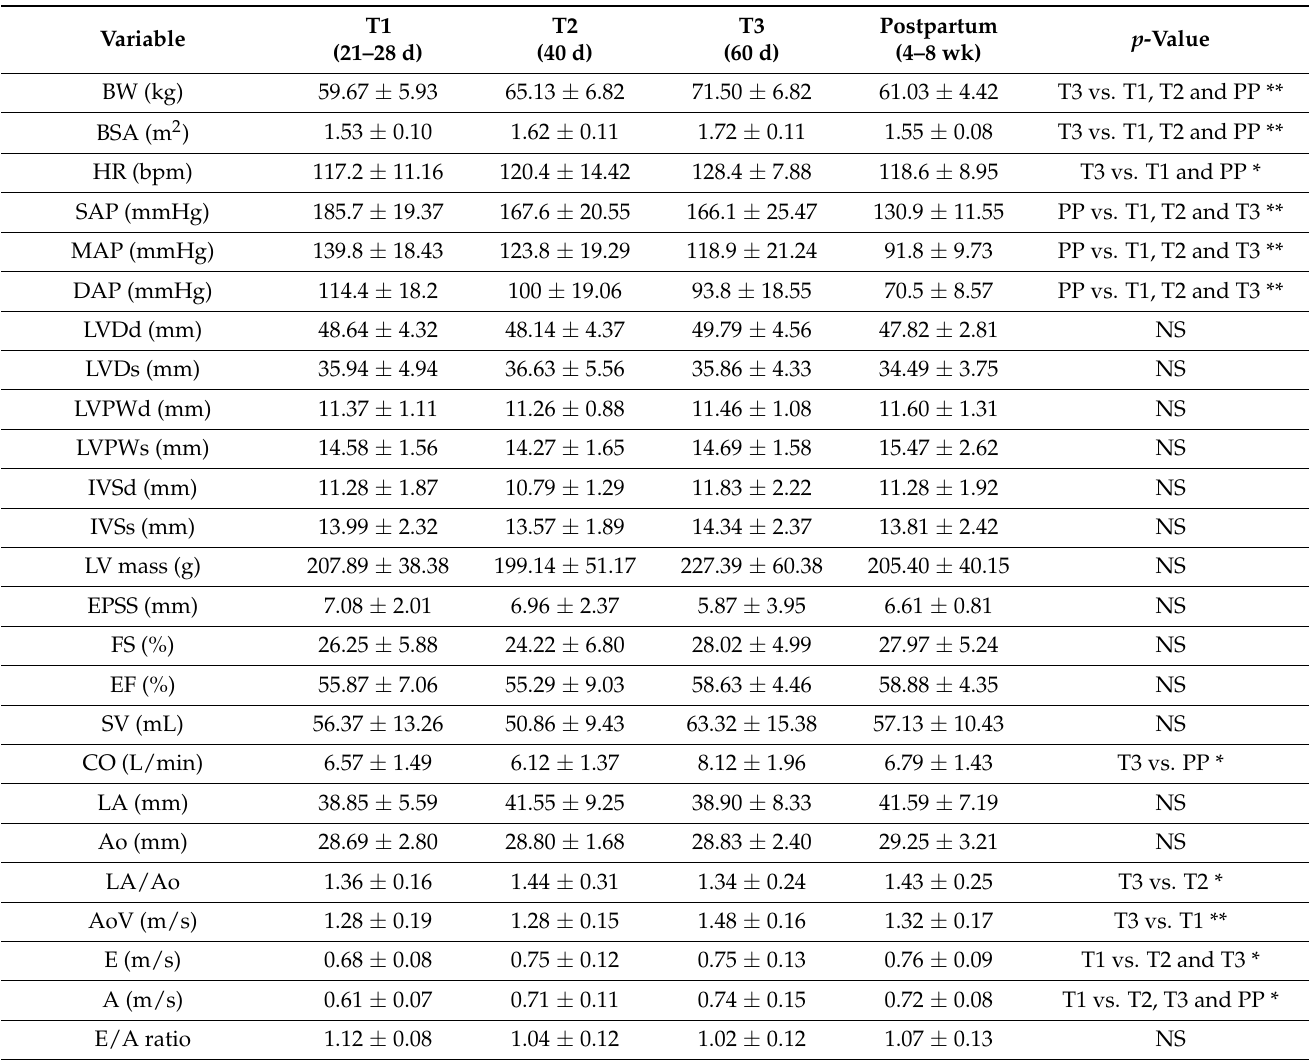
Table 1. Clinical and echocardiographic variables (mean ± SE). The P-value relates to the main effect of time on echocar- diographic variables obtained at T1 (early pregnancy; days 21–28), T2 (mid pregnancy; day 40), T3 (late pregnancy; day 60), and PP (postpartum; 4 to 8 weeks after parturition). * p -value < 0.05, ** p -value < 0.01. BSA, body surface area. Rest of abbreviations as in the